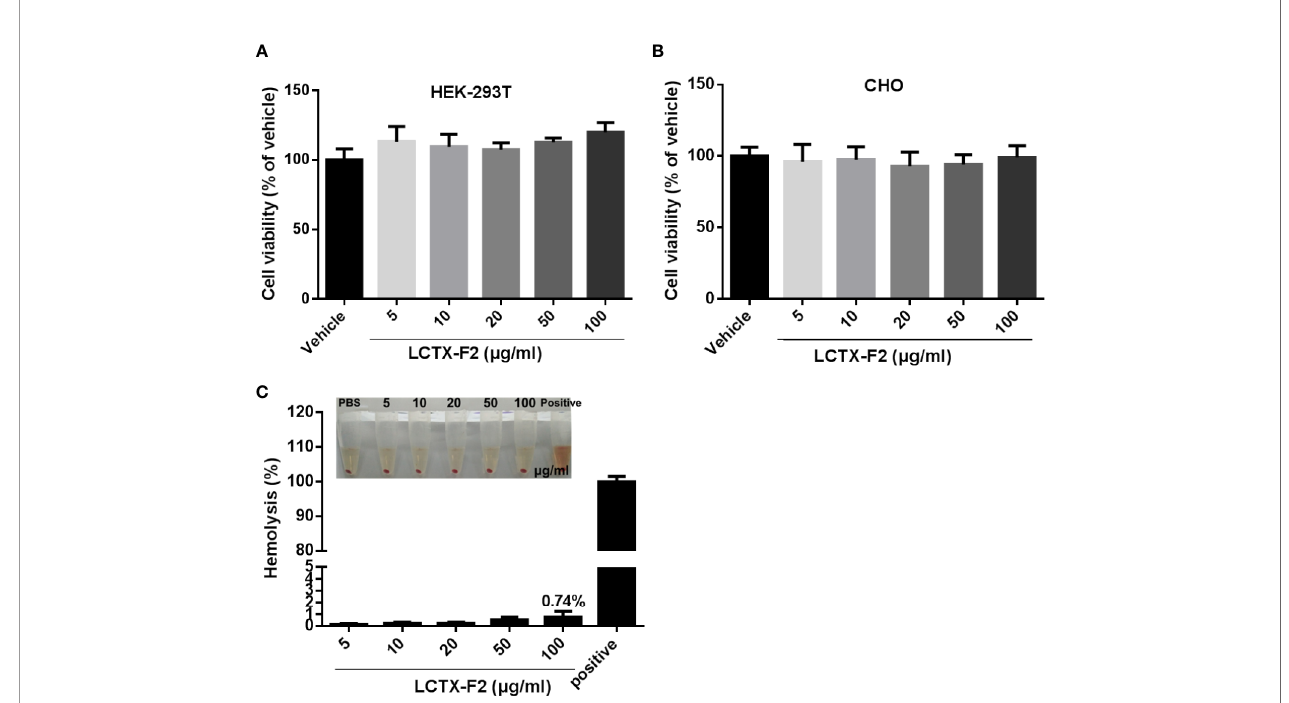
FIGURE 6 | The in fl uence of LCTX-F2 on normal cells or cell lines. LCTX-F2 did not affect the viability of HEK-293T (A) or CHO (B) cells. (C) Incubation with LCTX- F2 (0 – 100 µg/ml) did not elicit hemolytic effects against red blood cells.